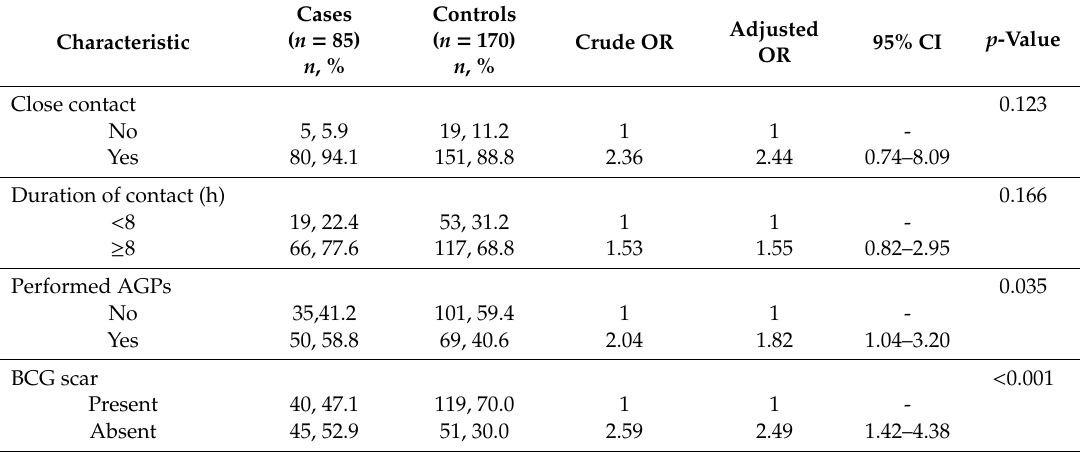
Table 4. Adjusted odds ratios for LTBI associations with various risk